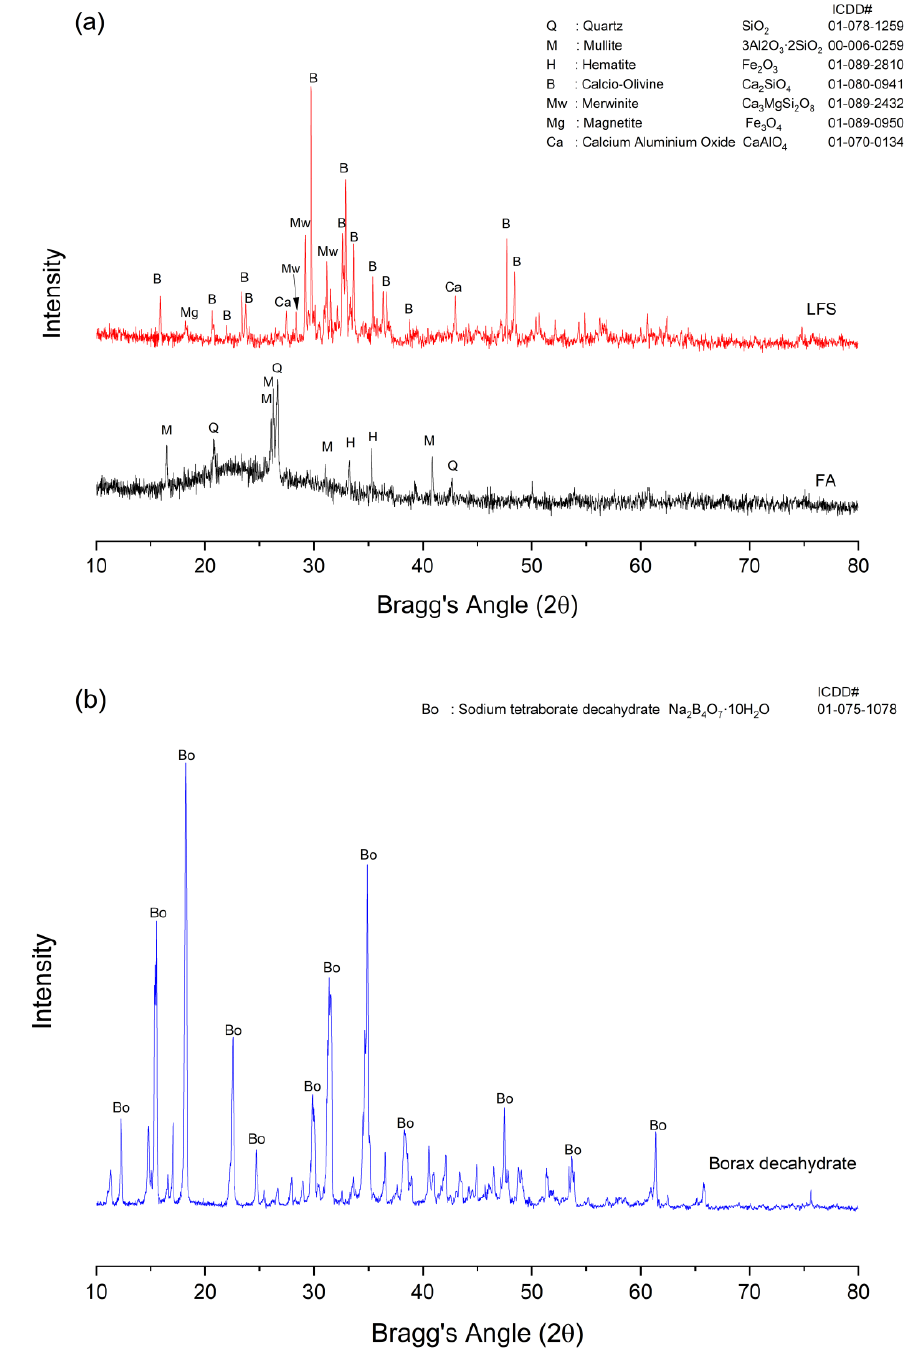
Figure 13. XRD diffractograms of ( a ) FA, LFS and ( b ) borax decahydrate. The XRD diffractograms of the FAS and FAB8 geopolymers at different